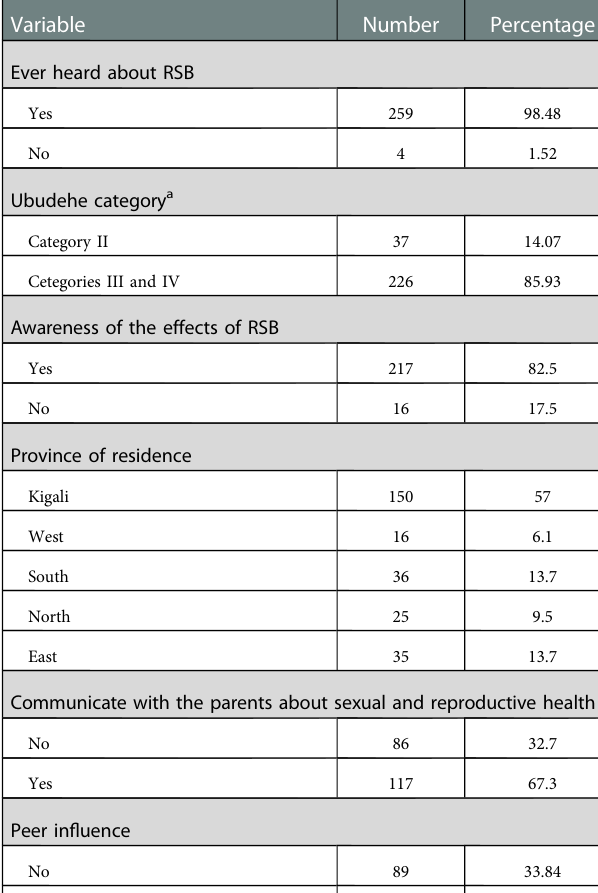
TABLE 1 Descriptive characteristics of the students ( N